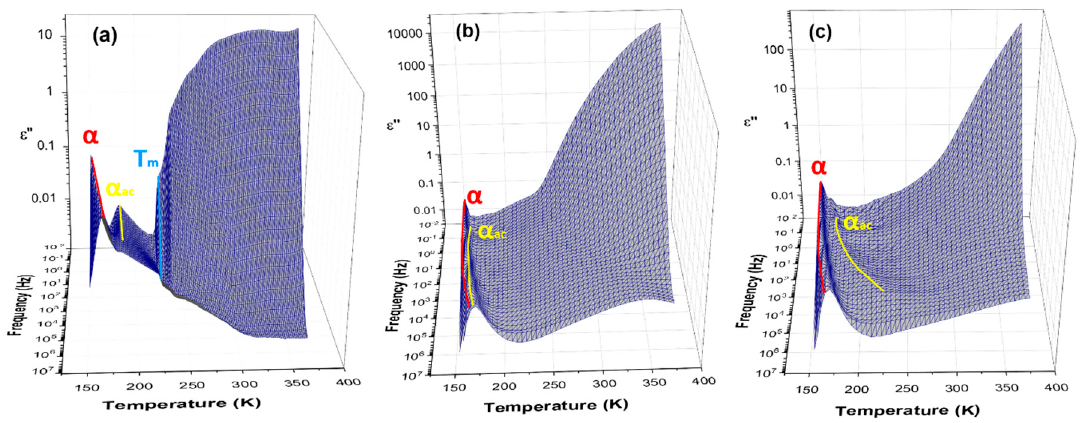
Figure 5. Frequency-temperature dependences of ε ” for ( a ) PDMS, ( b ) bpyPDMS, and ( c ) bpyPDMS-ZnCl 2 samples. The solid lines, drawn as a guide for eyes, indicate the detected relaxation processes α and α ac .